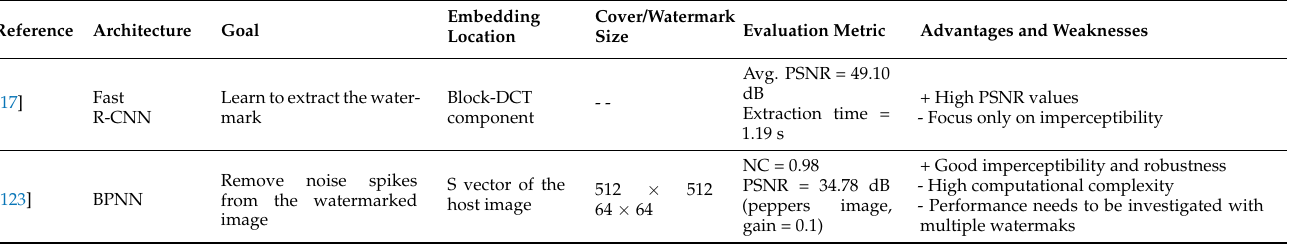
Table 5. Summary of learning-based image watermarking methods for extraction process Reference